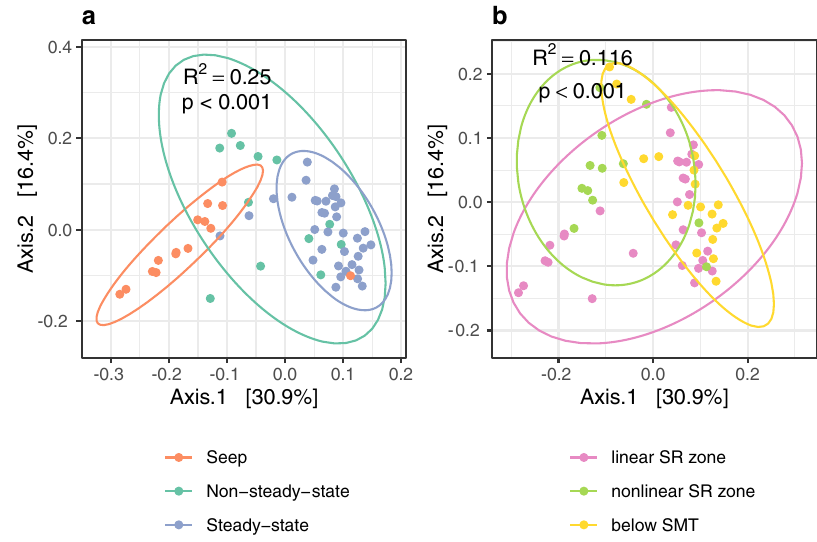
Fig. 7 Beta-diversity of communities from gas hydrate mounds. Principal Coordinates Analysis (PCoA) ordination of weighted Unifrac distances between all communities, colored according to states of methane dynamics ( a ), and redox zones within the sediment column ( b ). A Hellinger transformation was applied to ASV count tables before calculating the distance matrix. PERMANOVA tests verify distinct community structures present across states and redox zones, with R 2 and p -values shown in corresponding plots. SR sulfate reduction, SMT sulfate-methane of methane. Rates of AOM are approximately an order of mag- may be slow-growing anaerobic fermenters of organic matter. nitude higher than the steady-state cores (Fig. 2), supporting the Growth of bio fi lms at SMTs may also be supported over long growth of ANME/SRB and decreasing microbial community timescales, if given steady supplies of methane and sulfate. In diversity. In Fig. 8c, gas seepage and the presence of hydrates at Fig. 8b, recent methane in fl ux into shallower sediment horizons PC1029 indicate methane is at or above saturation in porewaters stimulates AOM and consumes sulfate, shoaling the SMT, and the throughout the core. Sulfate is delivered into the sediment diffusion of sulfate from seawater cannot balance the upward fl ux